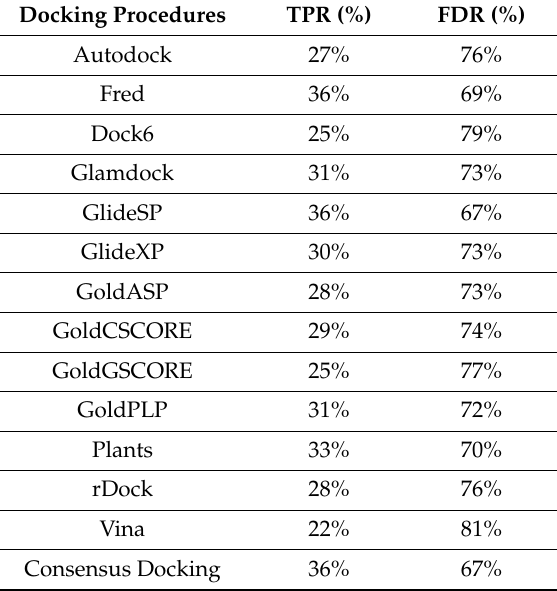
Table 2. True positive rate (TPR) and false discovery rate (FDR) values obtained for the 13 tested docking procedures, and for the consensus docking approach. Both the TPR and FDR values are reported as percentages of the maximum achievable